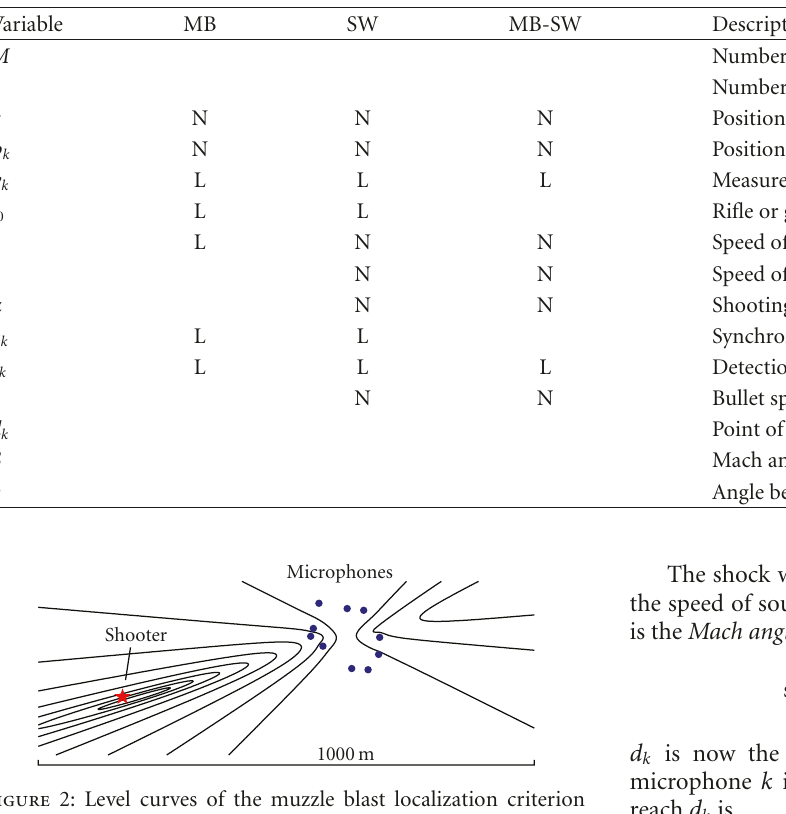
Table 1: Notation. MB, SW, and MB-SW are di ff erent models, and L/N indicates if model parameters or signals enter the model linearly (L) or nonlinearly (N).